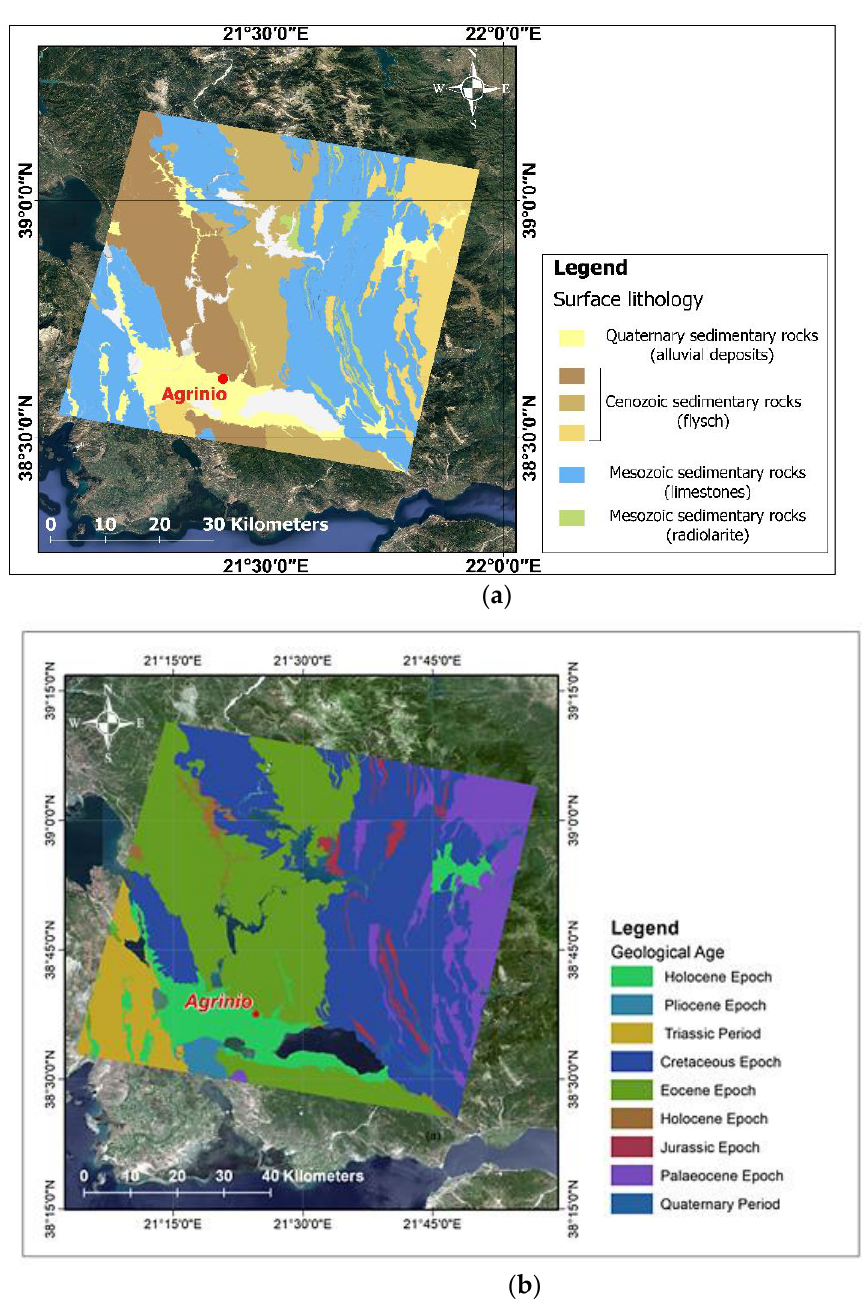
Figure 12. (a ) Surface lithology map ( b ) geological age map of the study area derived from EGDI 1:1 million scale OneGeology pan-European Surface Geology map.